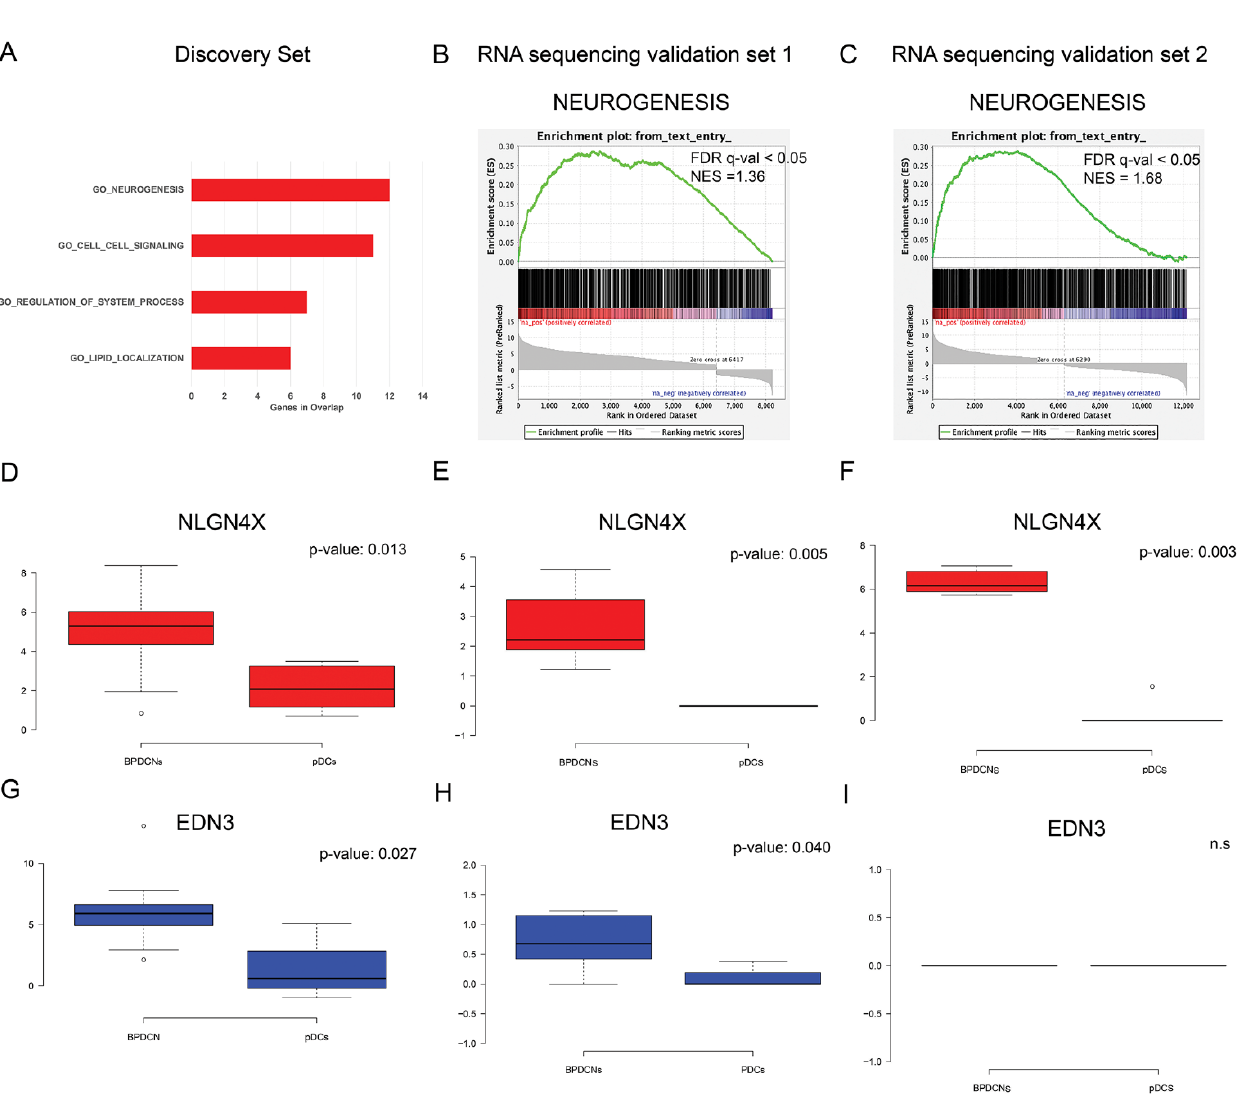
Figure 3. MiRNA network functional analysis. ( A ) The top four biological processes emerged, as significantly enriched in 57 network-genes by gene ontology (GO) analysis, are reported from the top to the bottom, from the most enriched to the lowest; ( B , C ) Pre-ranked Gene set enrichment analysis (GSEA) indicated that GO_neurogenesis gene set was significantly enriched in the RNA sequencing transcriptome of BPDCN compared with pDC samples in RNA sequencing validation set 1 and 2, respectively. Normalized enrichment scores (NES) and false discovery rate (FDR) q -values are given for the gene set. ( D – F ) Box plots showed in red the relative mRNA expression of NLGN4X in discovery set in RNA sequencing validation set 1 and 2, respectively. NLGN4X was significantly overexpressed in BPDCNs vs. pDCs in all the analyzed sets. ( G – I ) Box plots showed in blue the relative mRNA expression of EDN3 in discovery set and in RNA sequencing validation set 1 and 2, respectively. EDN3 was significantly overexpressed in the discovery set and RNA sequencing validation set. Box plots were created by webtool BoxPlotR. Center lines show the medians; box limits indicate the 25th and 75th percentiles as determined by R software; whiskers extend 1.5 times the interquartile range from the 25th and 75th percentiles, outliers are represented by dots. Statistical analysis was performed using Kruskal–Wallis rank sum test for multiple independent samples.